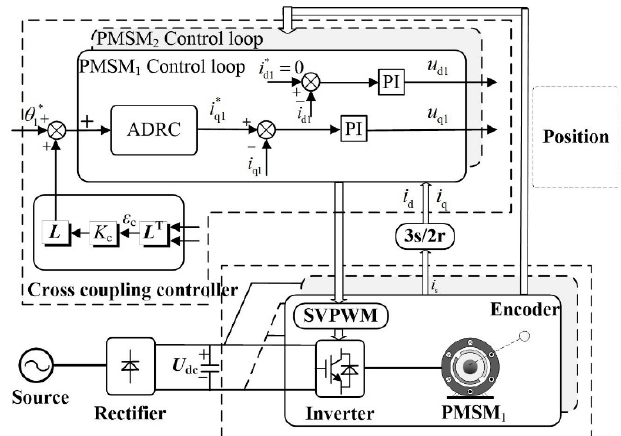
Figure 3. Structure diagram of position synchronous control system of dual permanent magnet syn- chronous motor.